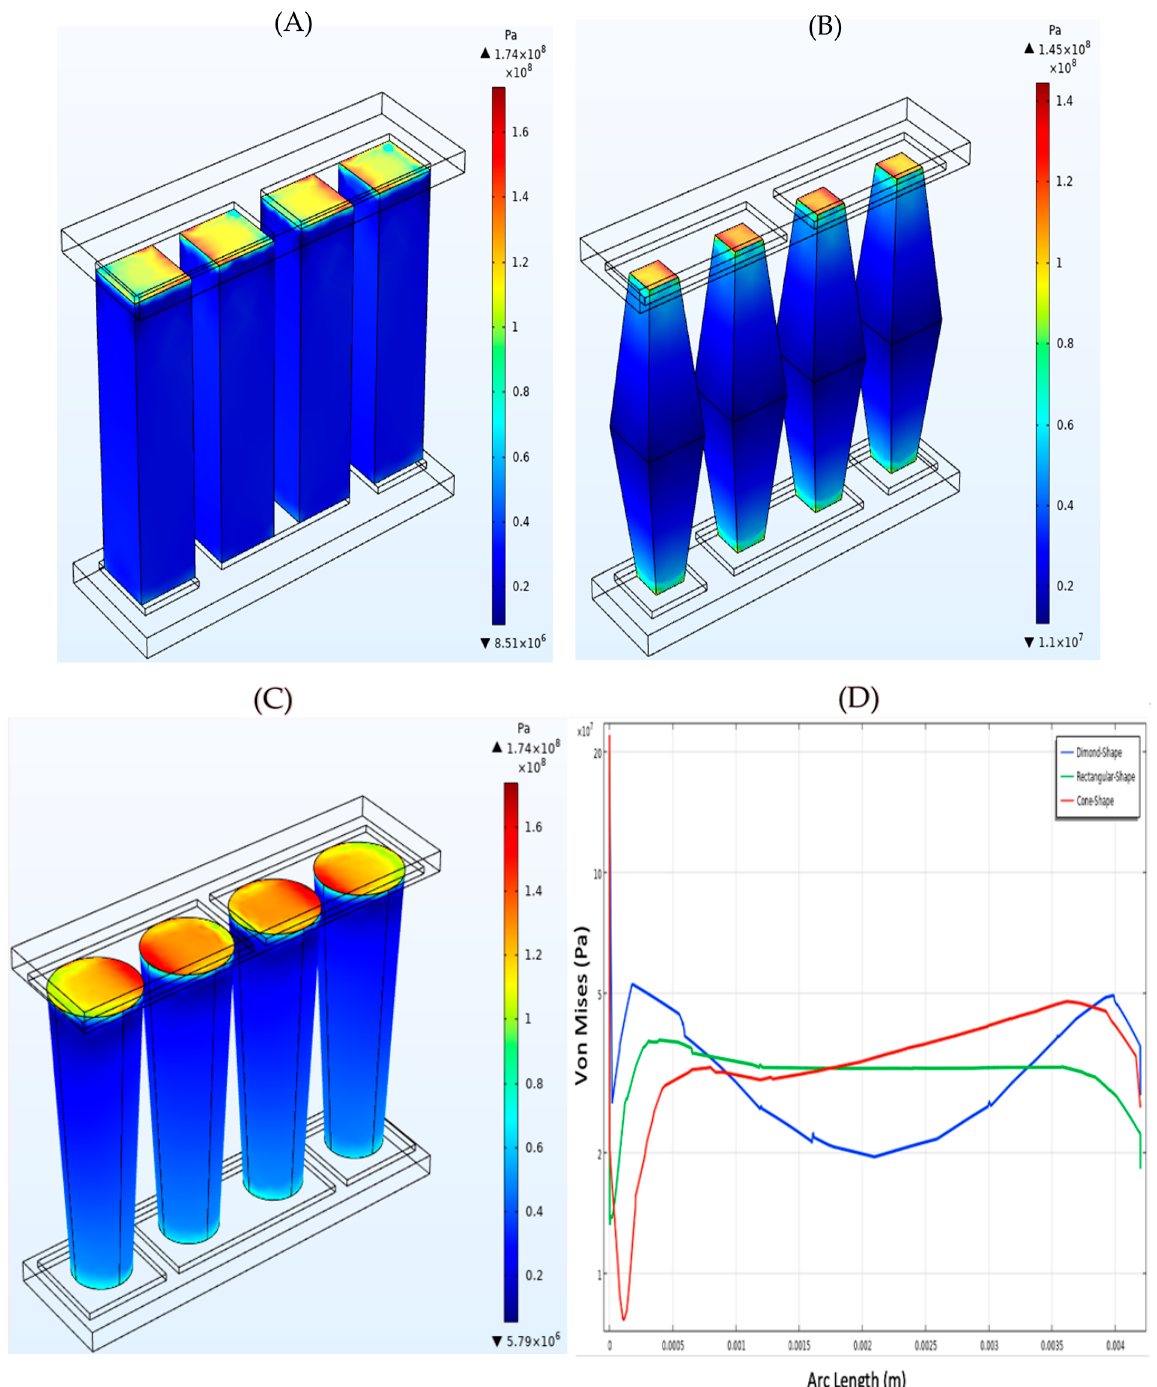
Figure 6. The Stress analysis in ( A ) Rectangular shape, ( B ) Diamond shape, ( C ) Cone shape and ( D ) Von Mises Compari-